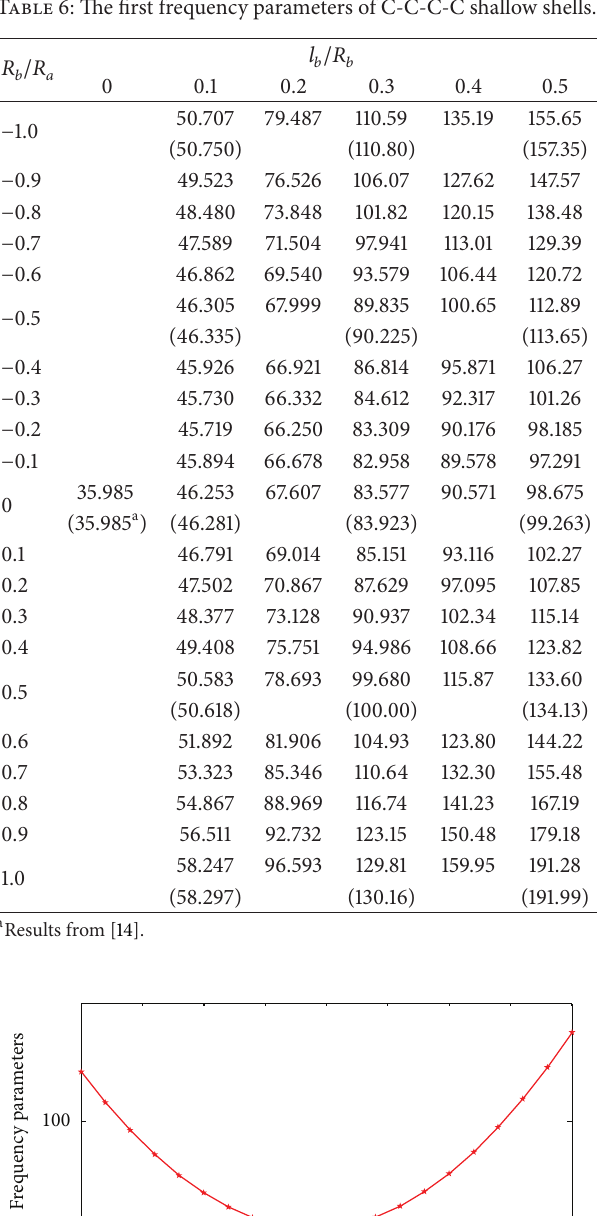
Table 7: The first frequency parameters of C-C-C-F shallow shells.